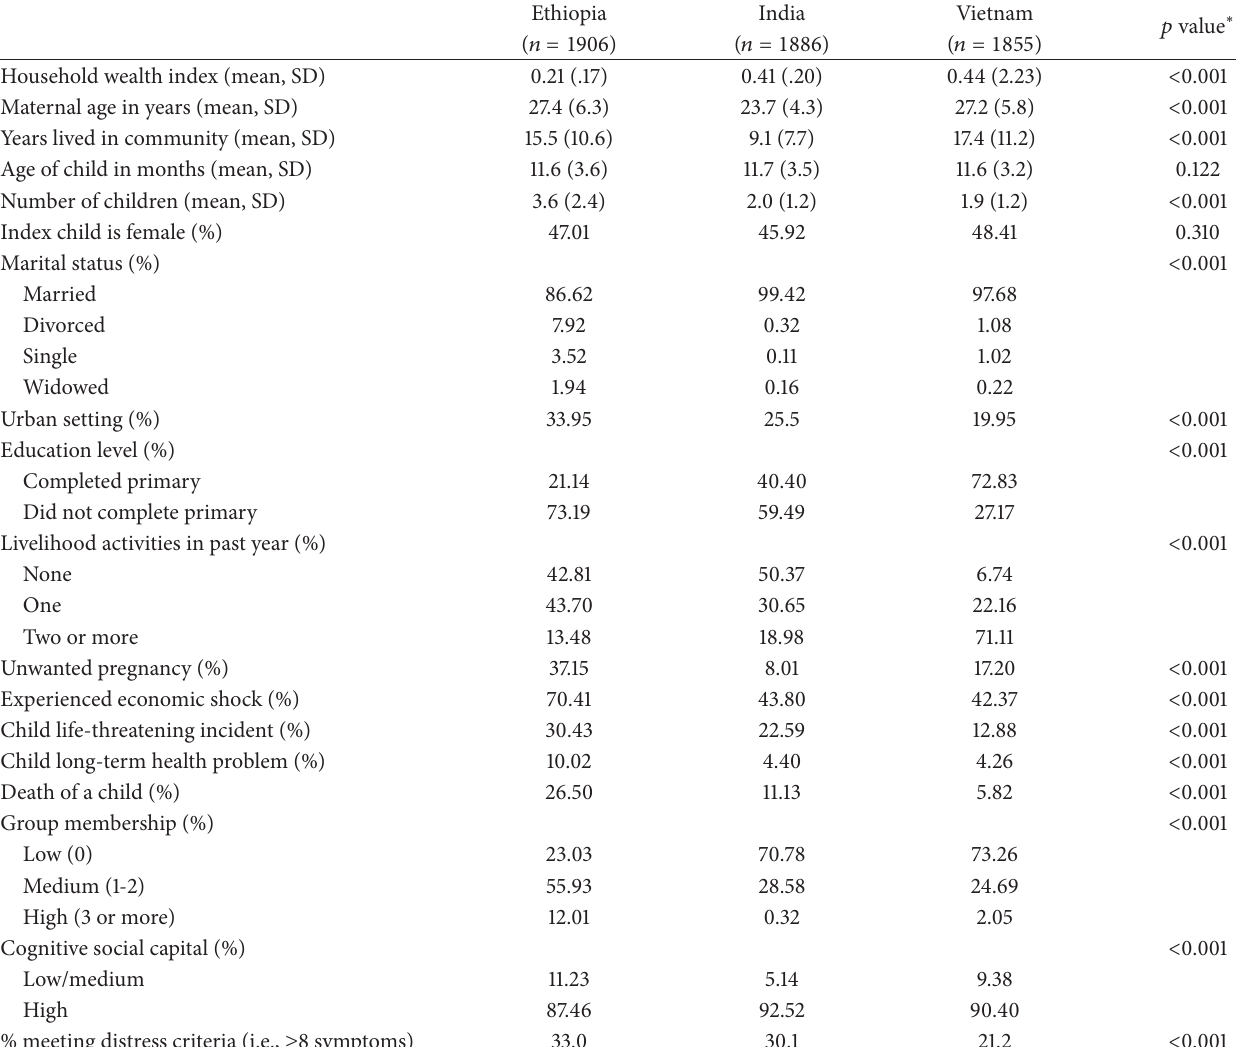
Table 2: Sample demographics by